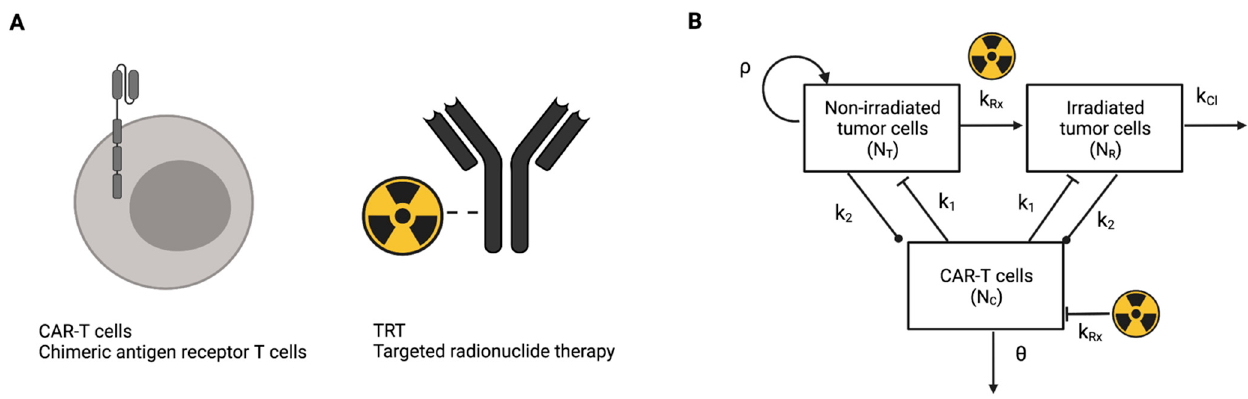
Figure 1. ( A ) Schematic diagram of CAR-T cells and TRT with antibody targeting. ( B ) Diagram of the mathematical model illustrating the relationships and interactions between non-irradiated and irradiated tumor cells and TRT and CAR-T cells.